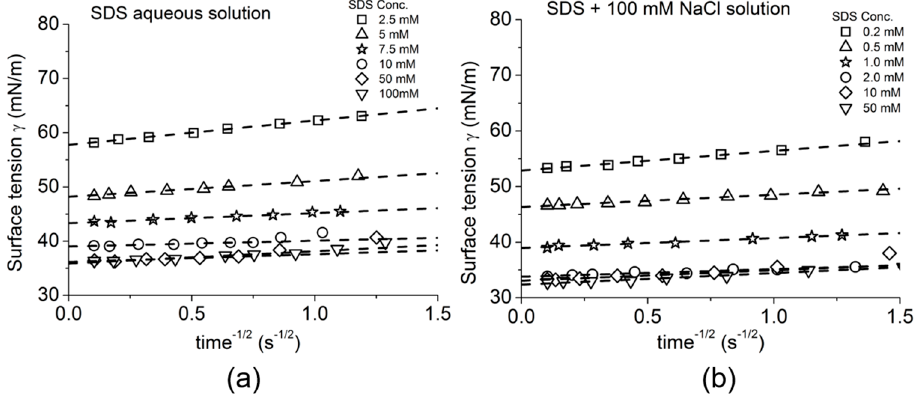
Figure 17. SDS dynamic surface tension at 20 ◦ C plotted according to the Ward–Tordai long-time approximation model Equation (7). SDS surface tensions are plotted as a function of t − 1/2 . ( a ) SDS surface tensions for different SDS aqueous solution concentrations made up in milli pure water from 2.5 to 100 mM. ( b ) SDS surface tensions for different SDS solution concentrations from 0.2 to 50 mM, made up in 100 mM NaCl. The intercept of each fitting line showed agreement with the equilibrium surface tension at each concentration. With permission from Elsevier [8].